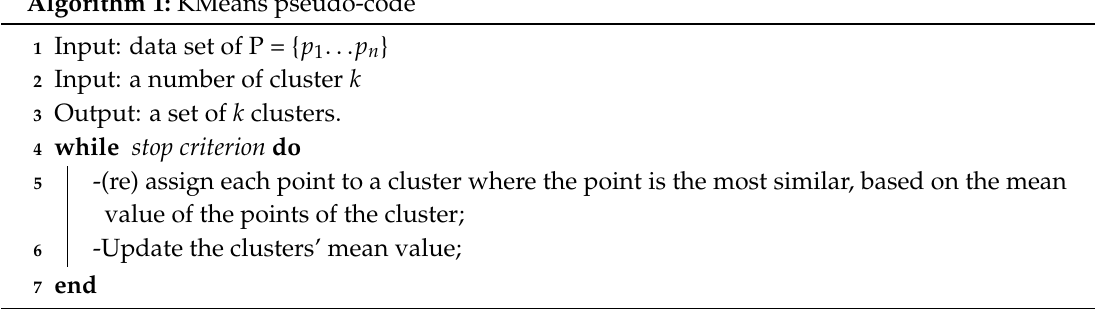
Algorithm 1: KMeans